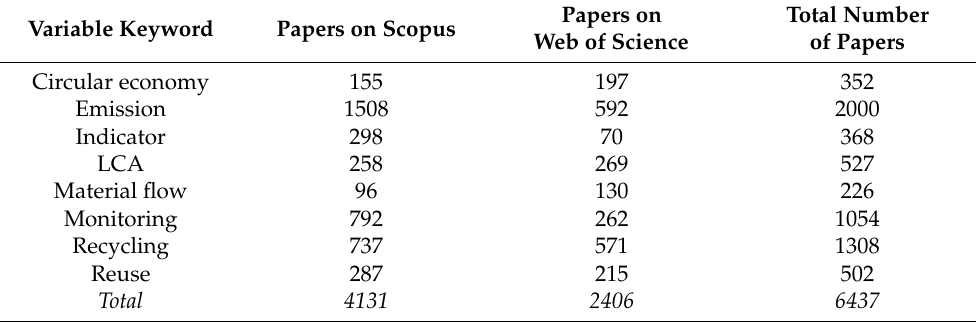
Table 1. Preliminary number of indexed journal articles (research and review articles) published in the years 2019–2023, as found in the Scopus and Web of Science databases. The first column indicates the last and variable research keyword that was combined with “steel” through the logical connector “AND”. This list refers to the first round of bibliographic research. The last column on the right reports the sum of found articles before removing duplicates that existed between the two databases. The bottom row reports the total number of articles found on Scopus, Web of Science and the total of the two.